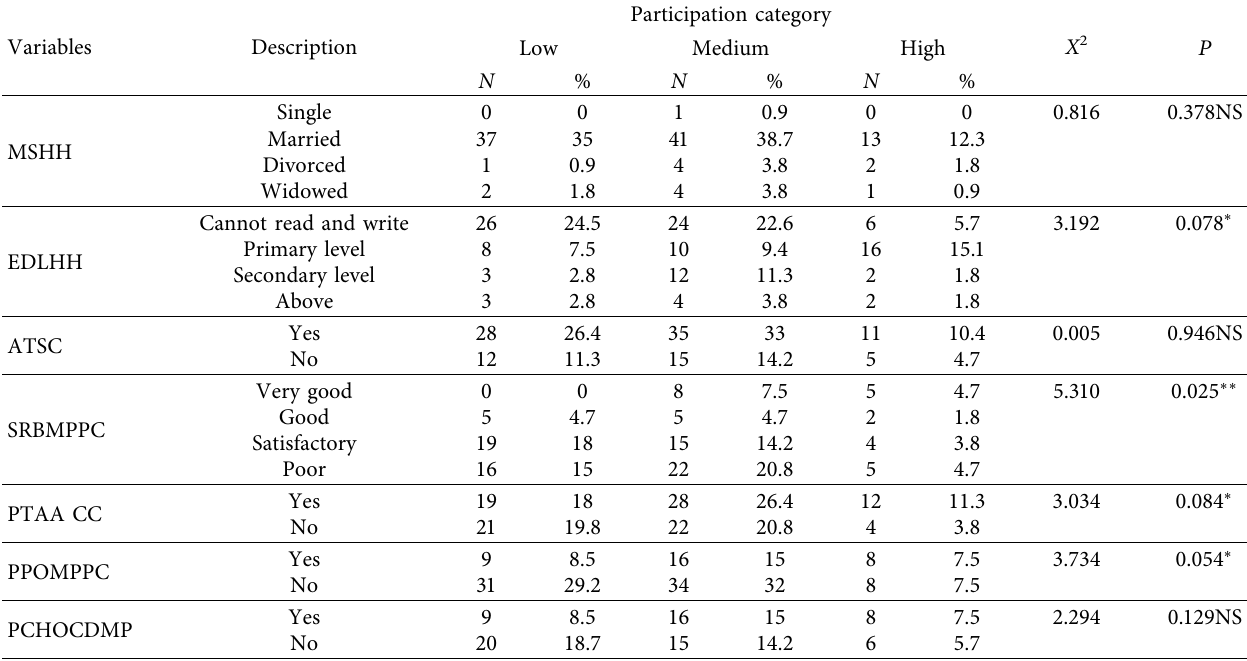
Table 13: Summary of the relationship between dummy variables and member participation.